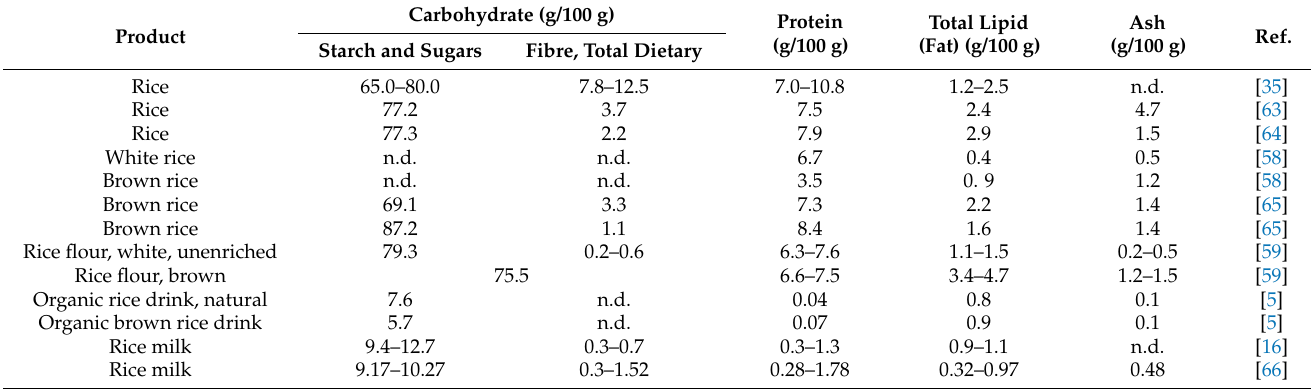
Table 1. Basic ingredients of rice product per 100